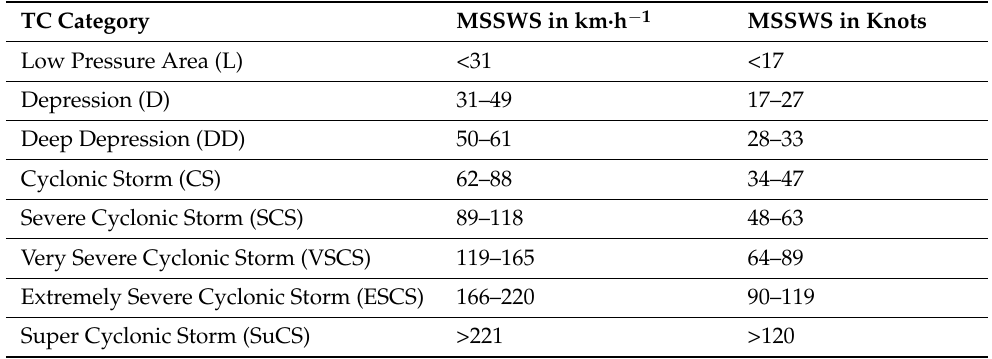
Figure 2. Time series of the ( a ) minimum central pressure (MCP, hPa) and ( b ) maximum 10 m sustained wind speed (M10SW, knots) for all the experiments, along with the IMD best estimates. Table 1. The categorization of TCs based on the maximum sustained surface wind speed (MSSWS) in the North Indian Ocean basin.